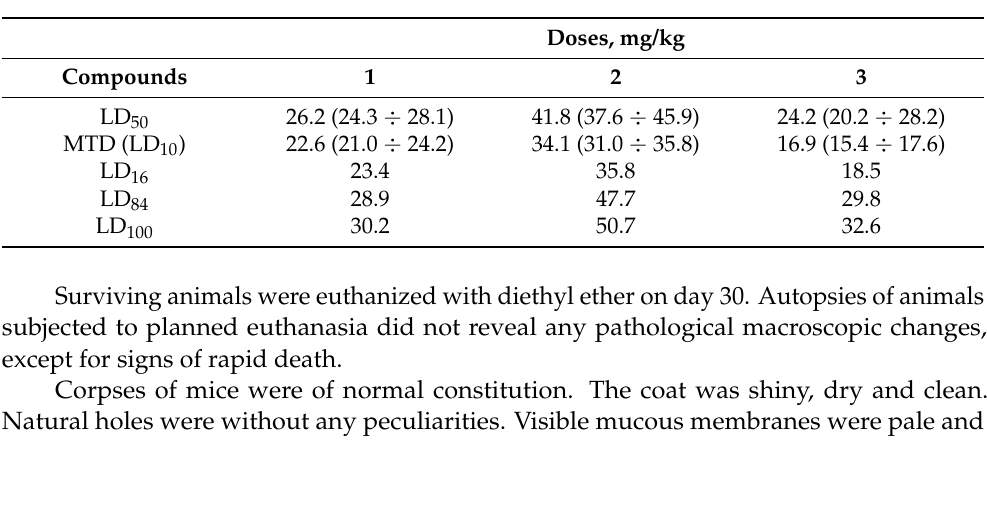
Table 2. Doses that characterize the toxicity of various compounds based on indolylmethylium